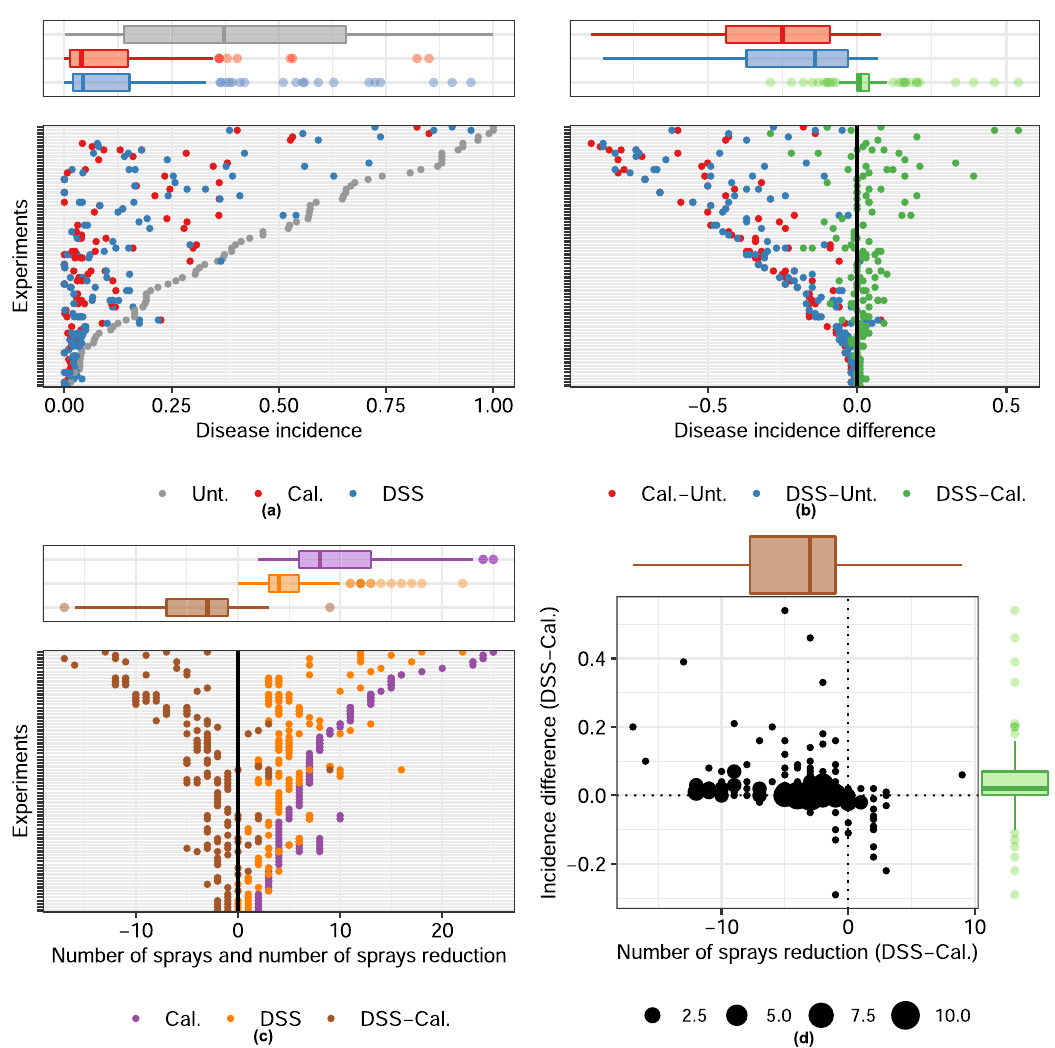
Fig. 1 Observed disease incidences and numbers of sprays in the 80 experiments. (a) Individual (per experiment) and overall distribution of disease incidence data for untreated (Unt), calendar-based (Cal) and DSS-based strategies (DSS); ( b ) individual and overall distribution of the measured differences in incidence between Cal vs. Unt (Cal-Unt), DSS vs. Unt (DSS-Unt) and DSS vs. Cal (DSS-Cal) strategies; ( c ) individual and overall distribution of the numbers of sprays with Cal and DSS strategies and observed reduction in the number of sprays between DSS vs. Cal strategies; ( d ) observed difference in disease incidence vs. reduction in the number of sprays for DSS vs. Cal strategies. Each point represents a pair of plots (DSS, Cal) within the same experiment. Box-and-whisker plot elements for ( a ) – ( d ): central line represents the median value; box limitis represents the fi rst ( Q 1 ) and the third ( Q 3 ) quantiles; upper whisker represents min(max(x), Q 3 + 1.5 IQR ; lower whisker represents max(min(x), Q 1 − 1.5 IQR ; IQR = Q 3 − Q 1 ; outliers are represented by